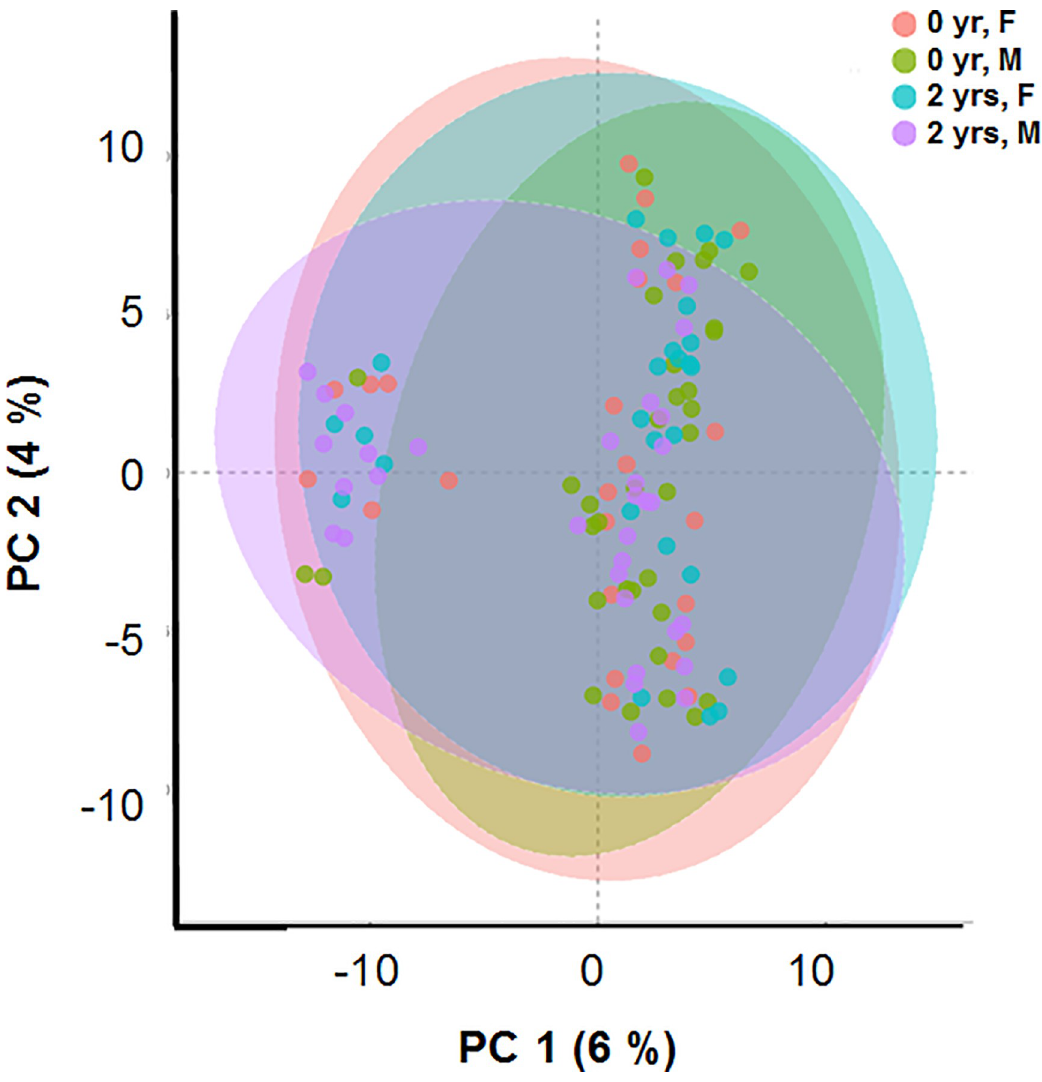
Fig 4. Principal component analysis (PCA) displaying Chow (red) and HFHC diet (cyan) fed baboon samples clustered as well as appearance of a new smaller cluster comprised of 32 baboon samples.